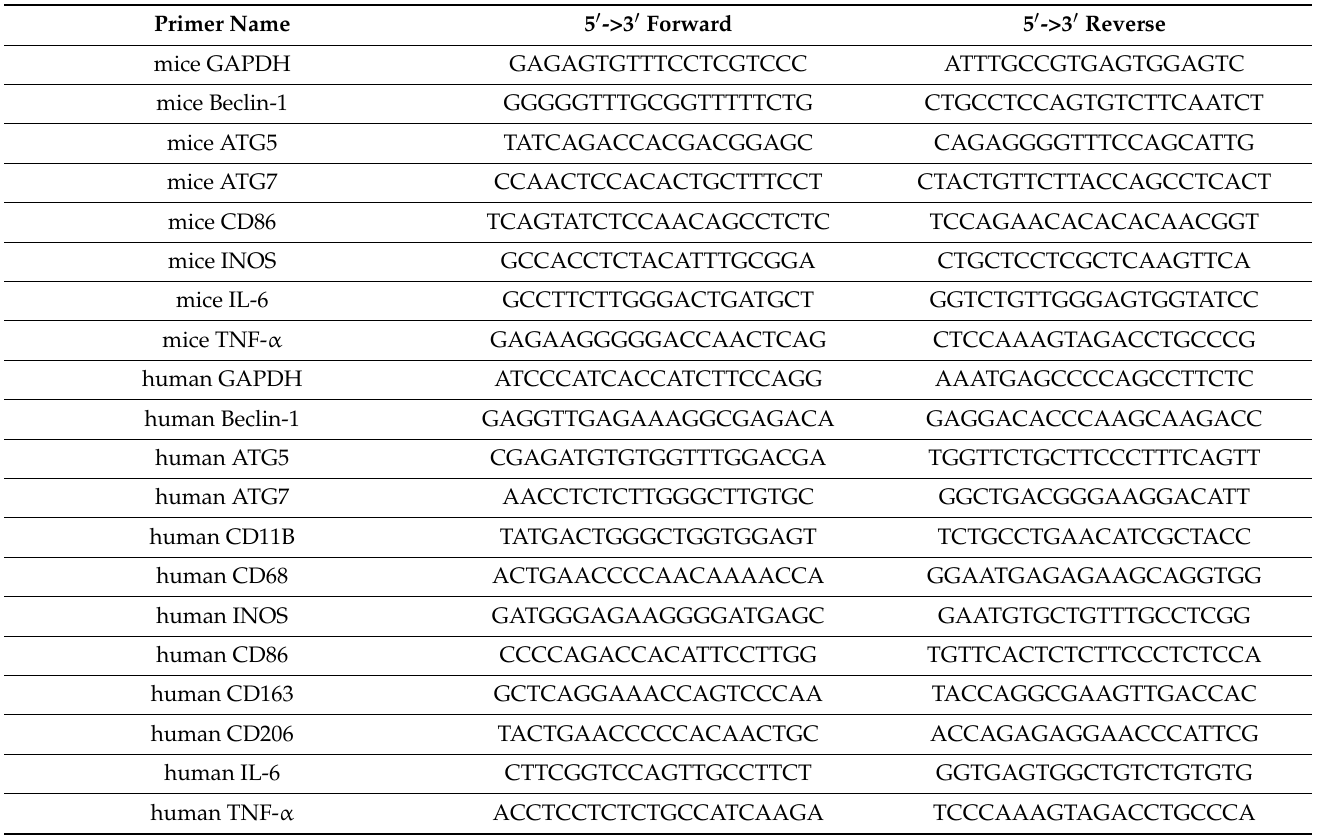
Table 1. Table of